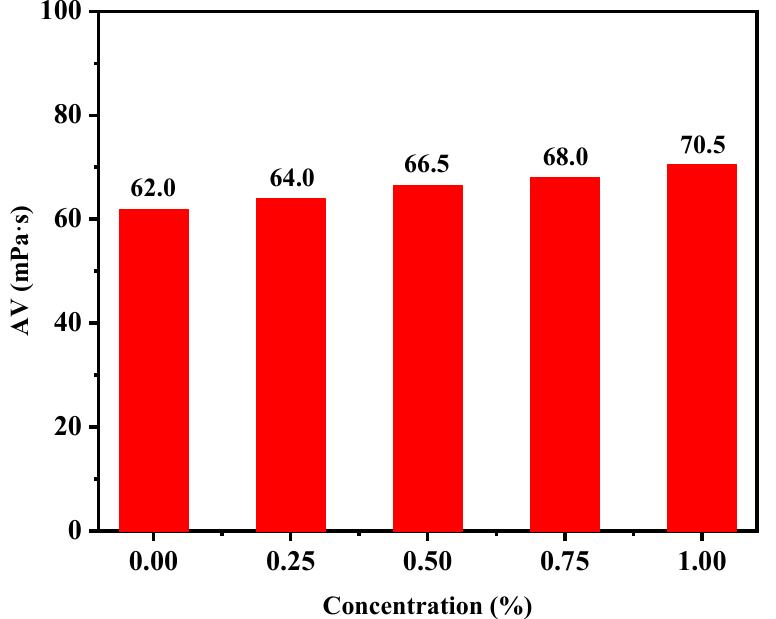
Figure 4. AV change curve after aging of oil-based drilling fluids with the addition of poly (MMA- BA-ST).